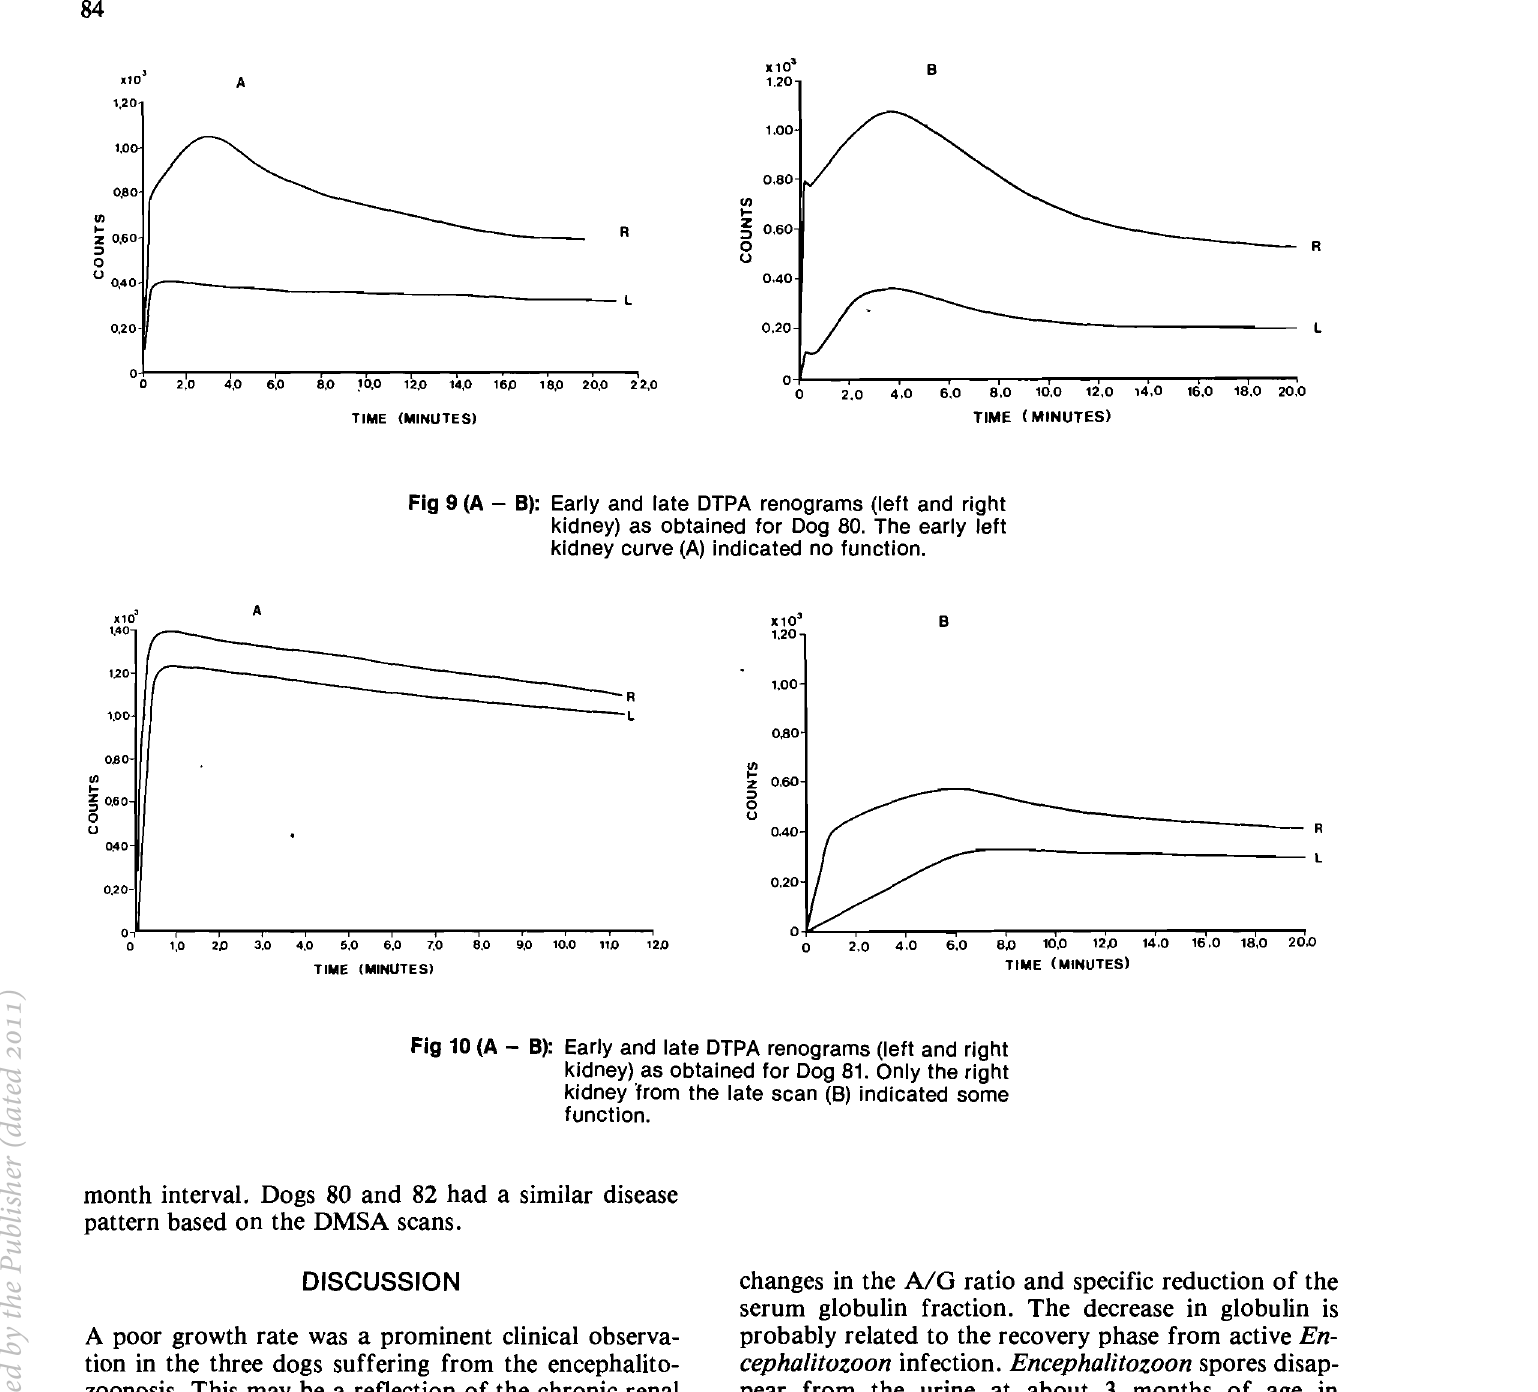
Fig 10 (A - B): Early and late DTPA renograms (left and right kidney) as obtained for Dog 81, Only the right kidney "from the late scan (8) indicated some